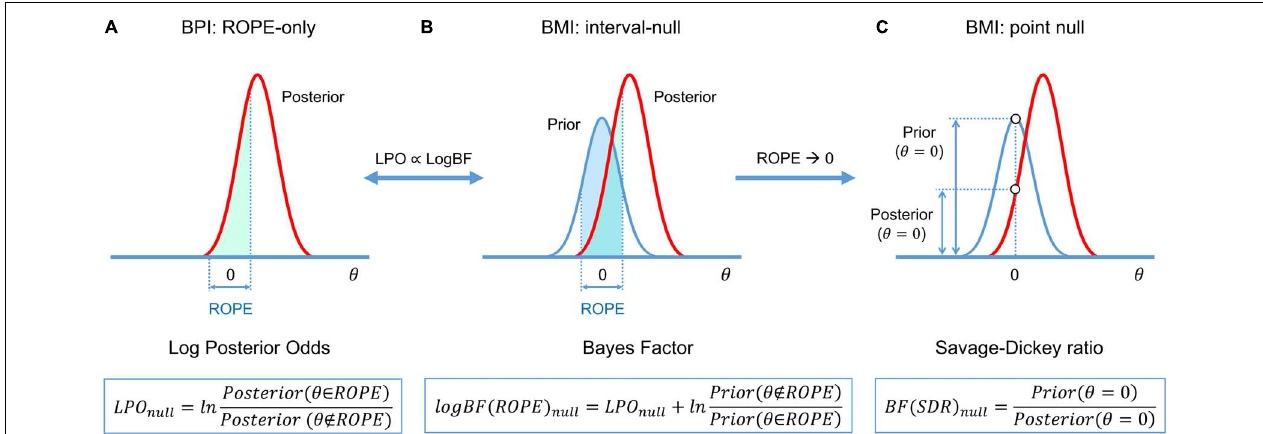
FIGURE 5 | Schematic of BFs used in BMI and their relation to LPO used in BPI. (A) BPI based on the ‘ROPE-only’ decision rule. (B) BF(ROPE) is related to the areas under the functions of the posterior and prior probability densities inside and outside the ROPE. (C) BF(SDR) is the relation between the posterior and prior probability at θ = 0. LPOs and BFs provide relative evidence for the null and alternative